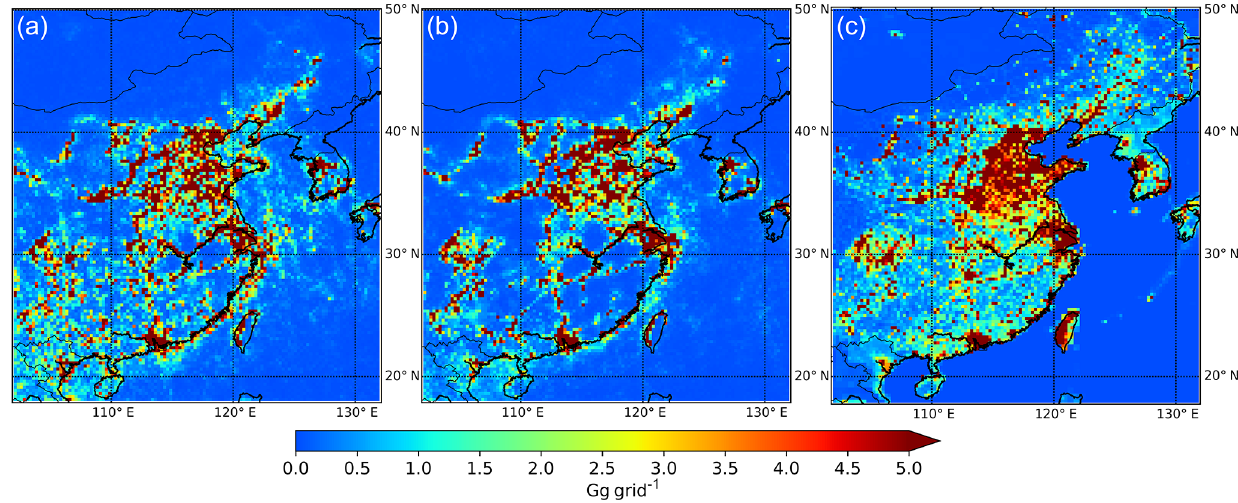
Figure 1. Maps for NO x emissions in the DECSO inventory, 2015 (a) ; the DECSO inventory, 2010 (b) ; and the MIX Asian inventory, 2010 (c) . The unit is gigagrams of NO 2 per grid